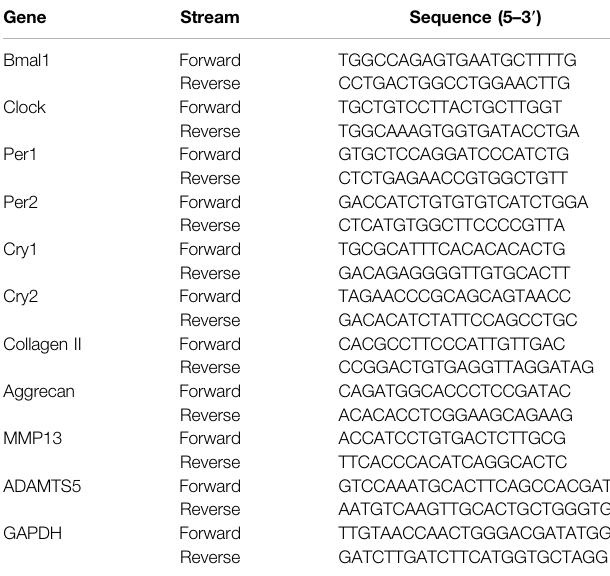
TABLE 1 | The rat primer sequences used in